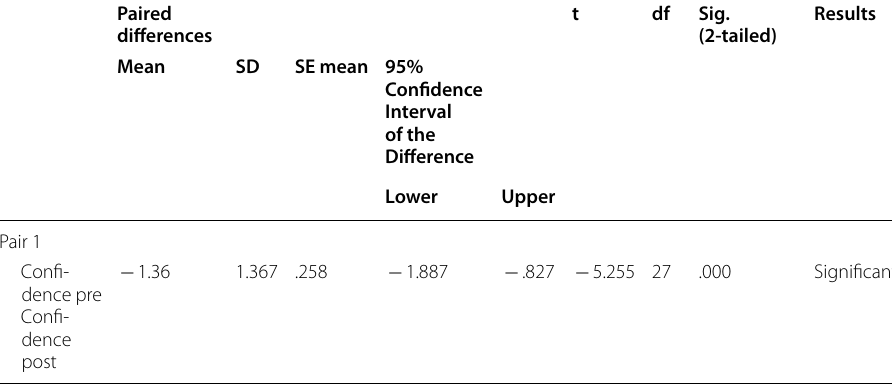
t df Sig. Results (2-tailed)